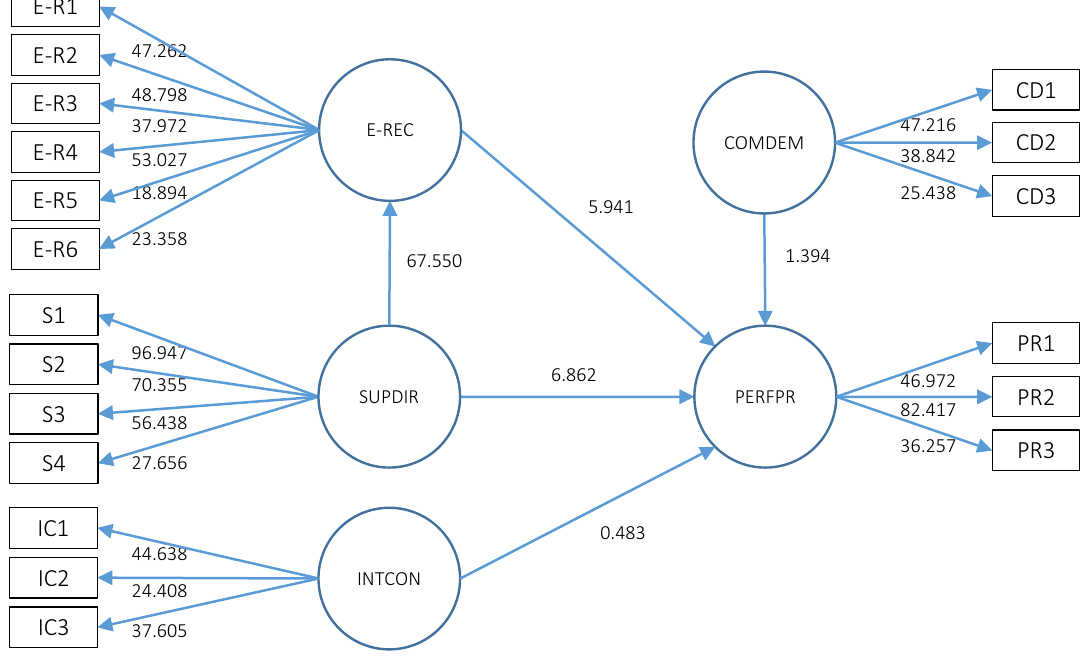
Figure 3. Direct relationships from the